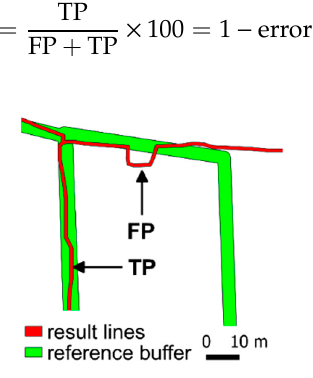
Figure 6. Correctness based on overlaying the buffered delineation and reference data to compute pixels being true positive (TP) or false positive (FP). These pixels are then summed to calculate (2) the error commission and (3) the correctness.